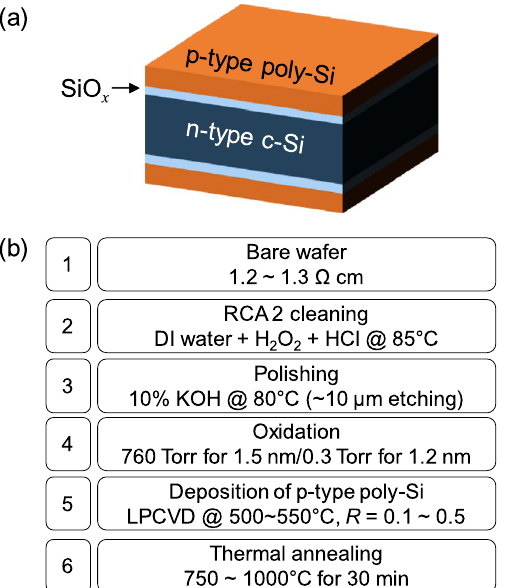
Figure 1. ( a ) Schematic of the symmetric SiO x /poly-Si stack structure of the hole-selective contacts used in our experiments and ( b ) the fabrication